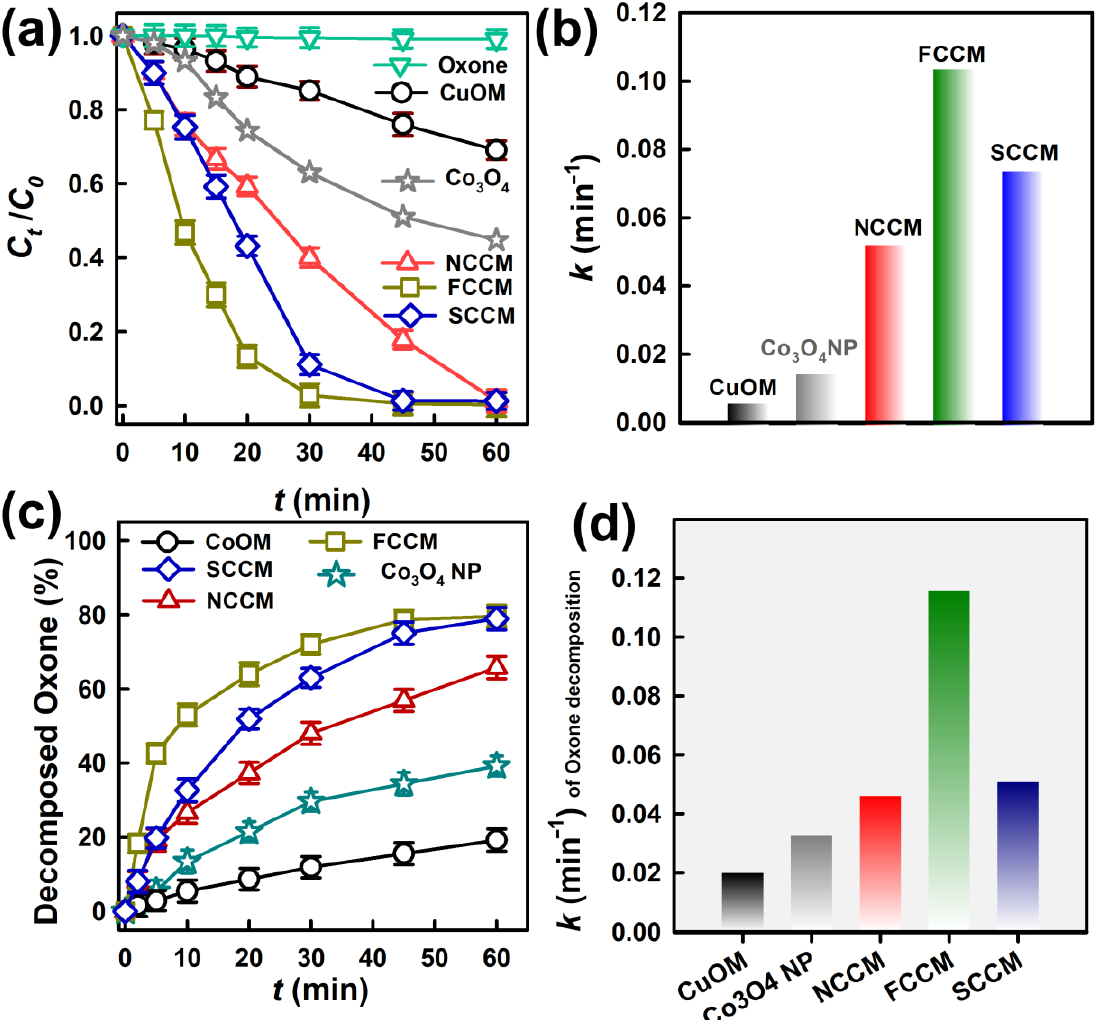
Figure 4. ( a ) Comparison of degradation of AR by Oxone alone, adsorption to catalysts, and Oxone activated by various catalysts, ( b ) decomposition of Oxone by different catalysts, ( c ) decomposed Oxone as a function of time, and (d) the kinetics of decomposed Oxone (Catalyst = 200 mg/L, Oxone = 200 mg/L, T = 30 °C).